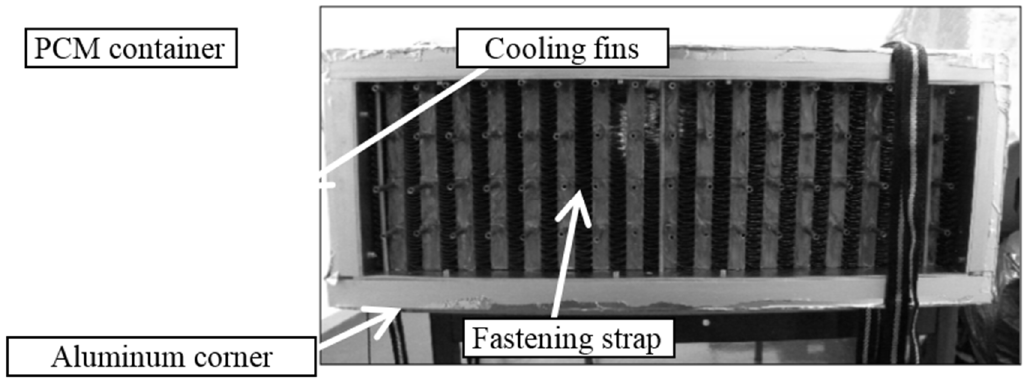
Figure 4. Front view of the heat storage system.